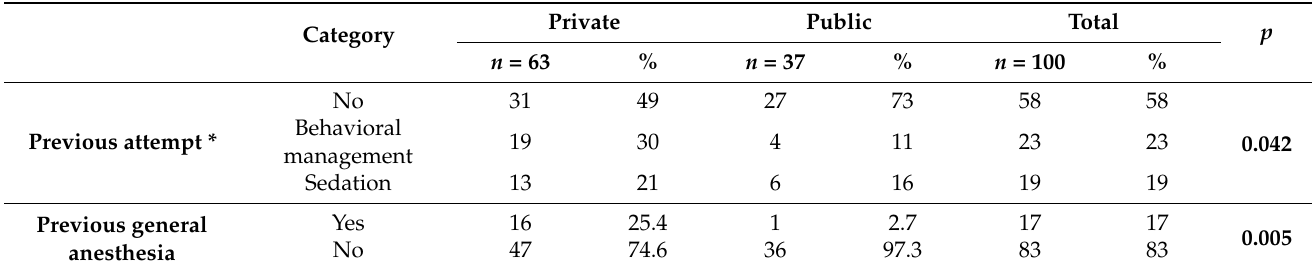
Table 6. The attempts of dental treatment prior to general anesthesia and previous GA